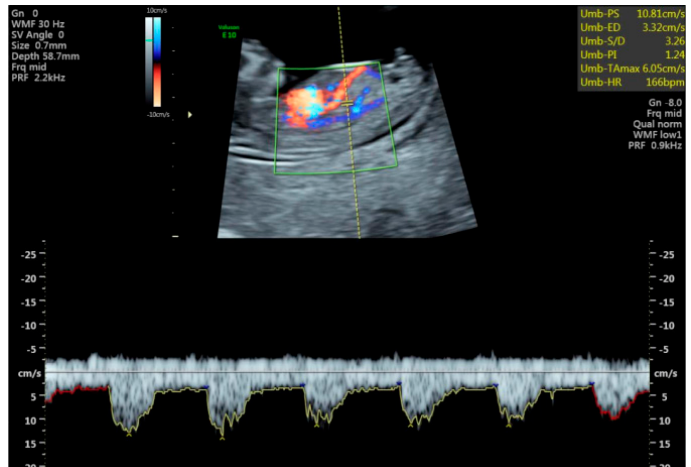
Figure 1. Longitudinal plane view of 12-week fetus showing the umbilical vein, the ductus venosus and the descending thoracic aorta on color flow. The hepatic artery is the vessel coming into close contact with the ductus venosus.